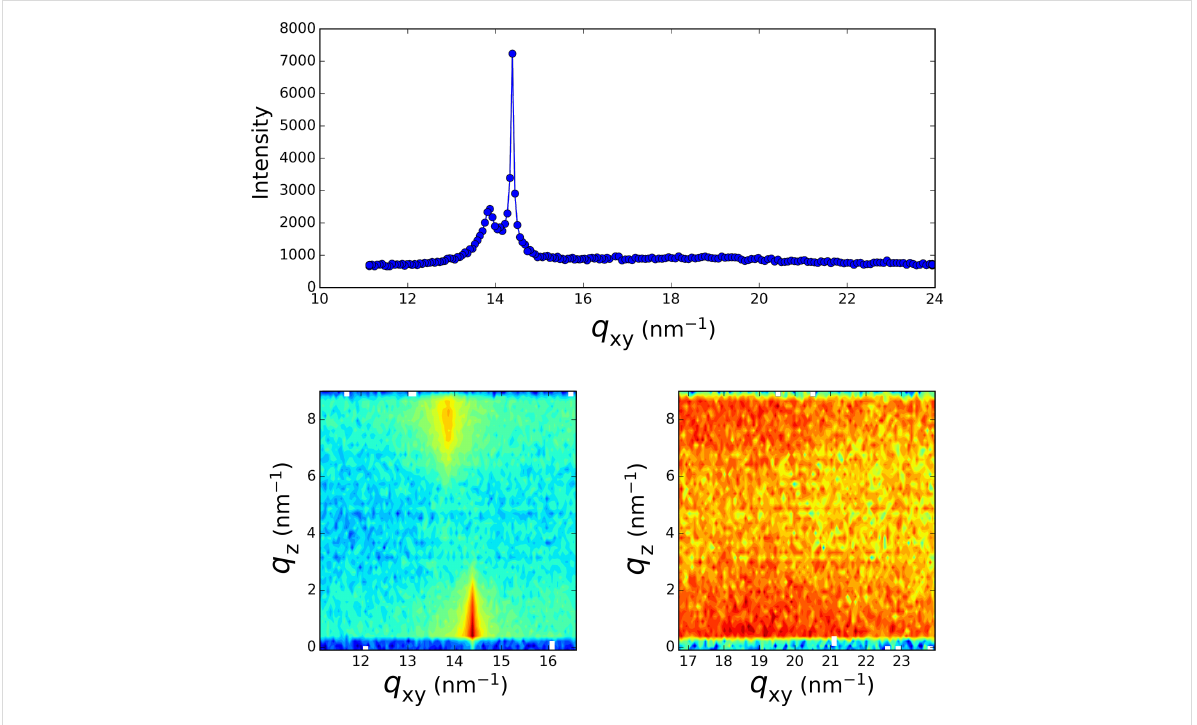
Figure 2: Grazing incidence X-ray diffraction spectrum taken at the beginning of the irradiation process of Figure 1c. Top: q z integrated spectrum, Bottom: q xy − q z intensity maps.